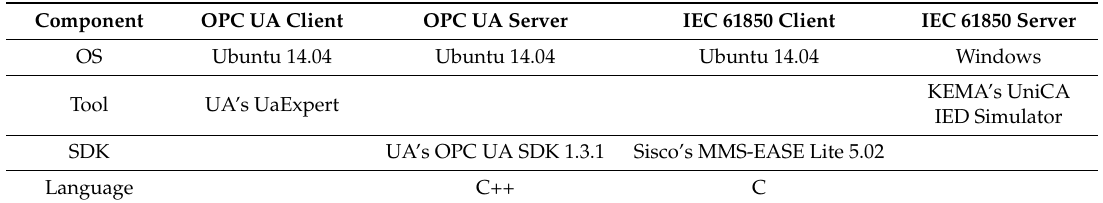
Figure 12. Network diagram between IEC 61850 and OPC UA. Table 5. Test environments [17–20].